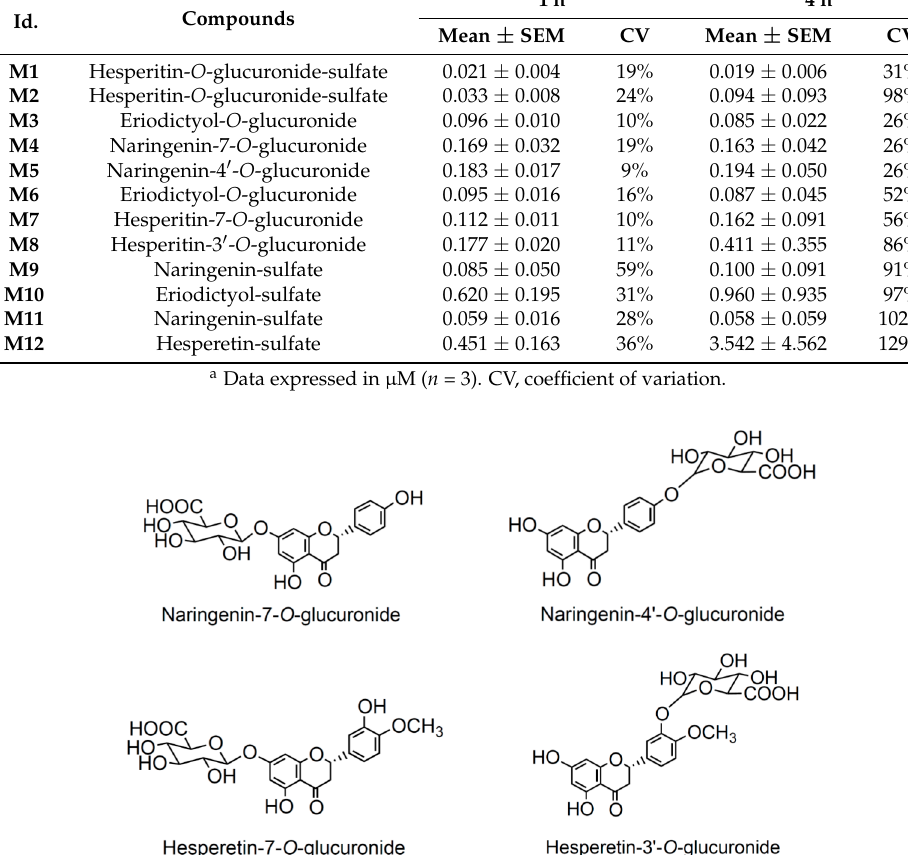
Table 3. Concentration of flavanone metabolites in plasma after consumption of bergamot juice a . Id.